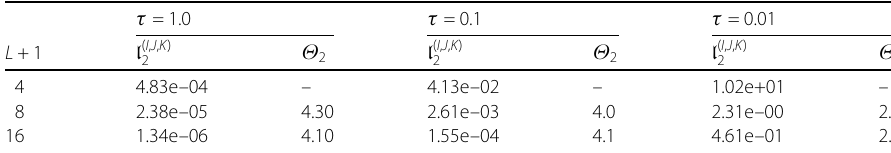
Table 1b Errors and order for UM-FOCS in Example 5.1